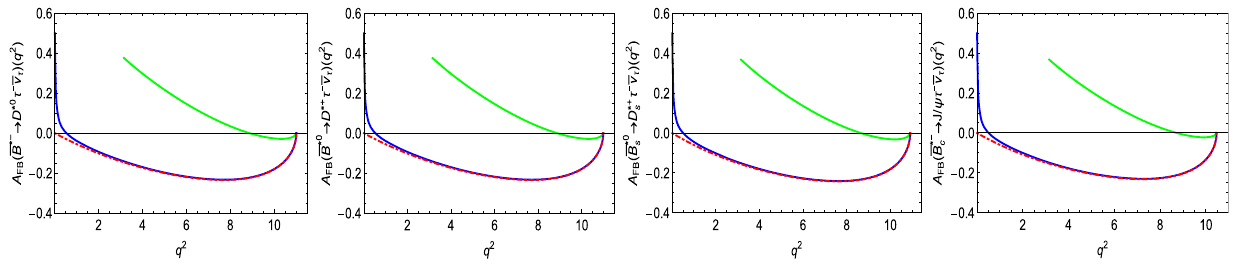
( q 2 ) as a function of q 2 for ¯ B ∗ → Vl − ¯ ν FB